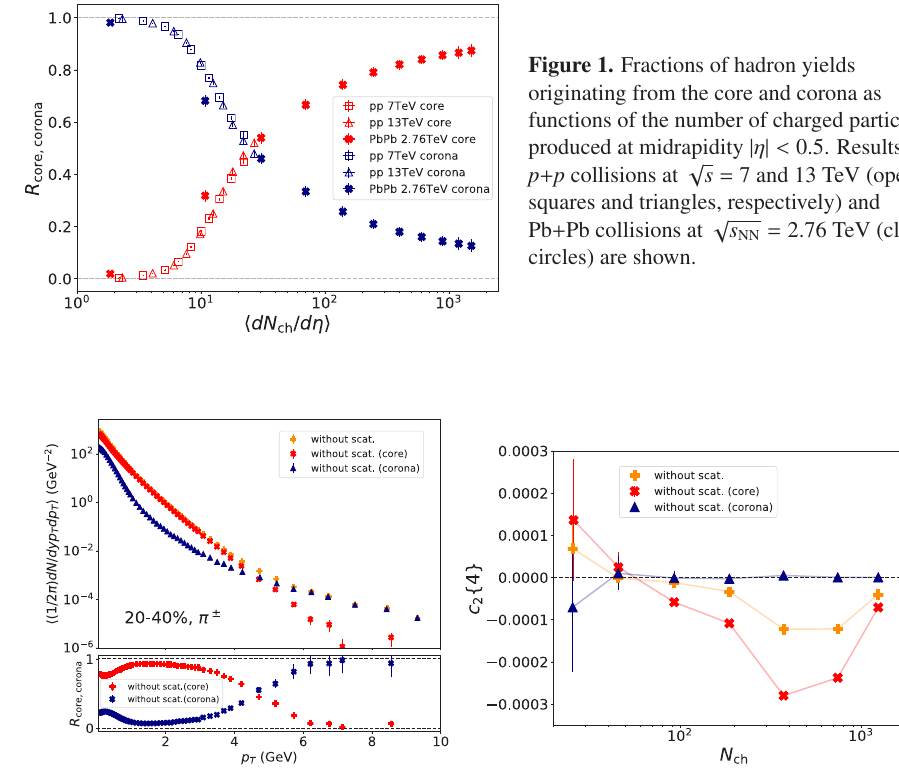
Figure 2. (Left) Charged pion p T spectra obtained from 20-40% centrality class of Pb + Pb collisions at √ s NN = 2 . 76 TeV are shown in the upper panel. Fractions of core and corona contributions in each p T bin are shown in the lower panel. (Right) Four-particle cumulant of charged particles as a function of the number of charged particles produced at midrapidity obtained in Pb + Pb collisions at √ s NN = 2 . 76 TeV. The solid lines are guides to the eyes. In both left and right figures, results with switching o ff hadronic rescatterings are shown in orange crosses and their breakdowns into the core and corona contributions are shown in red diagonal crosses and blue triangles,